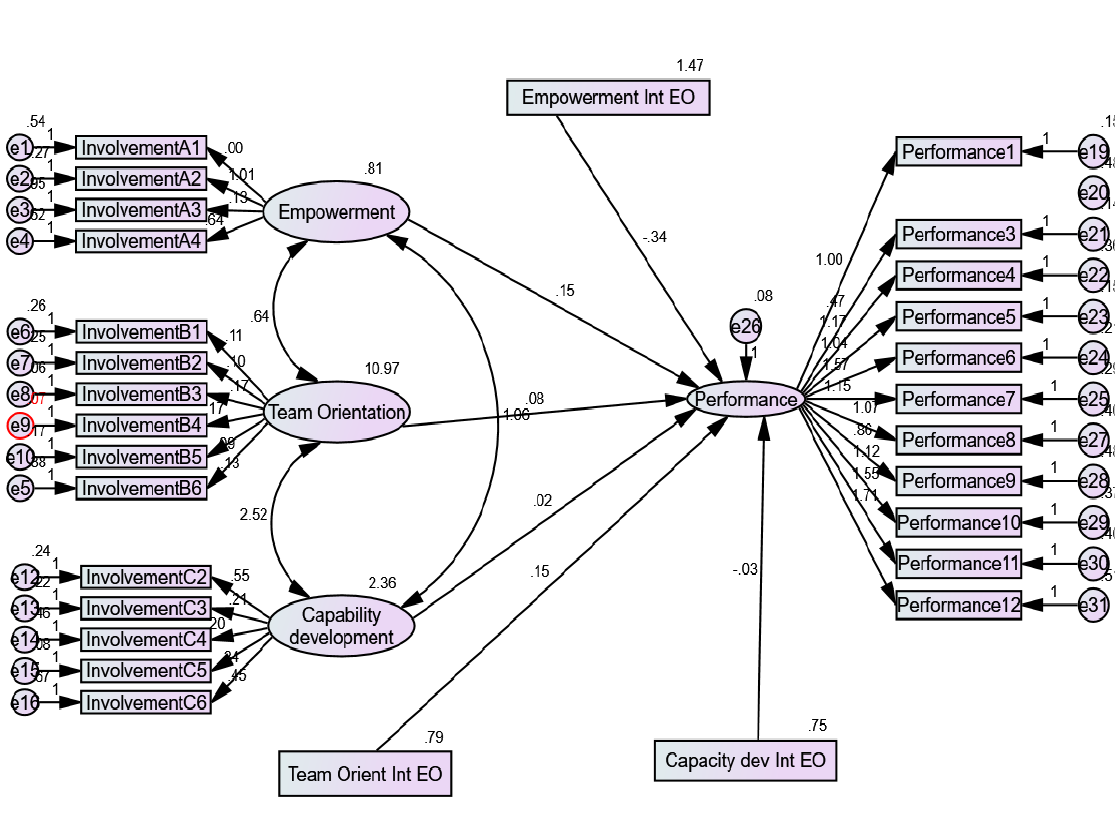
Figure 2: Path diagram for the structural model on the moderating effect of Entrepreneurial